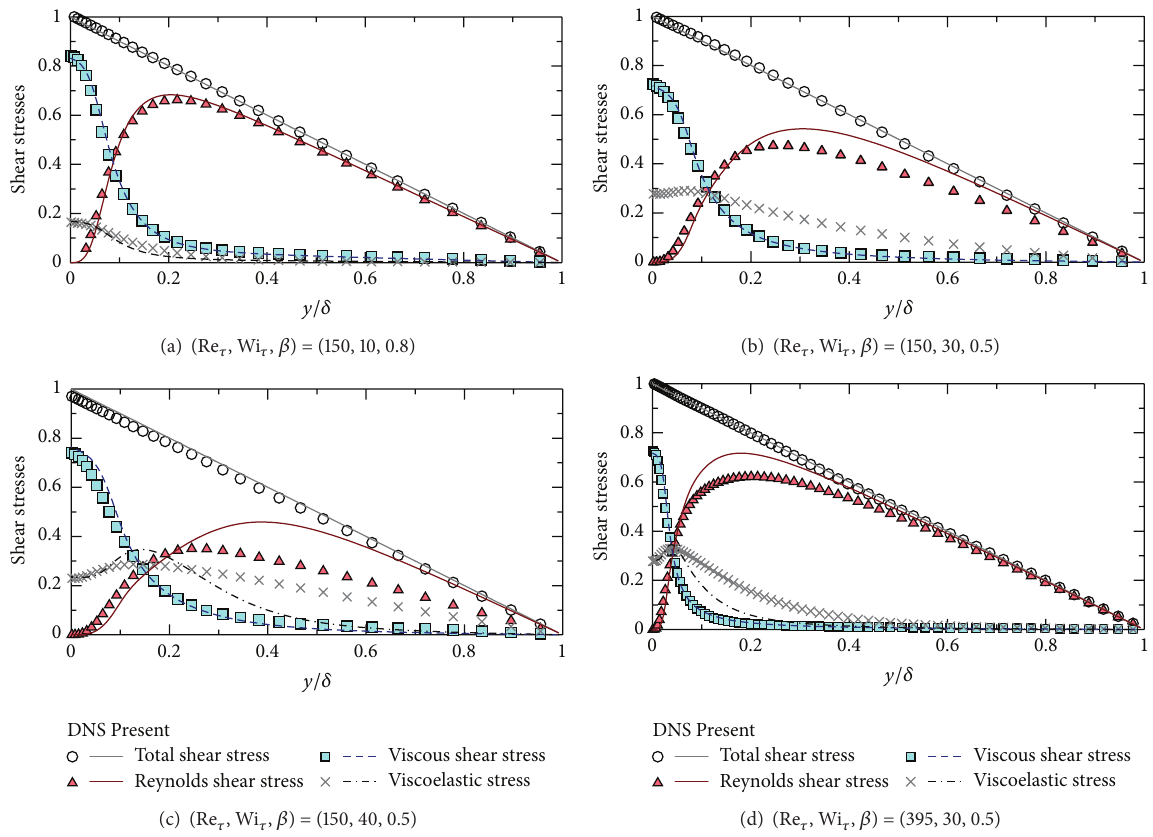
Figure 11: Shear stress profiles of drag-reducing viscoelastic flow in